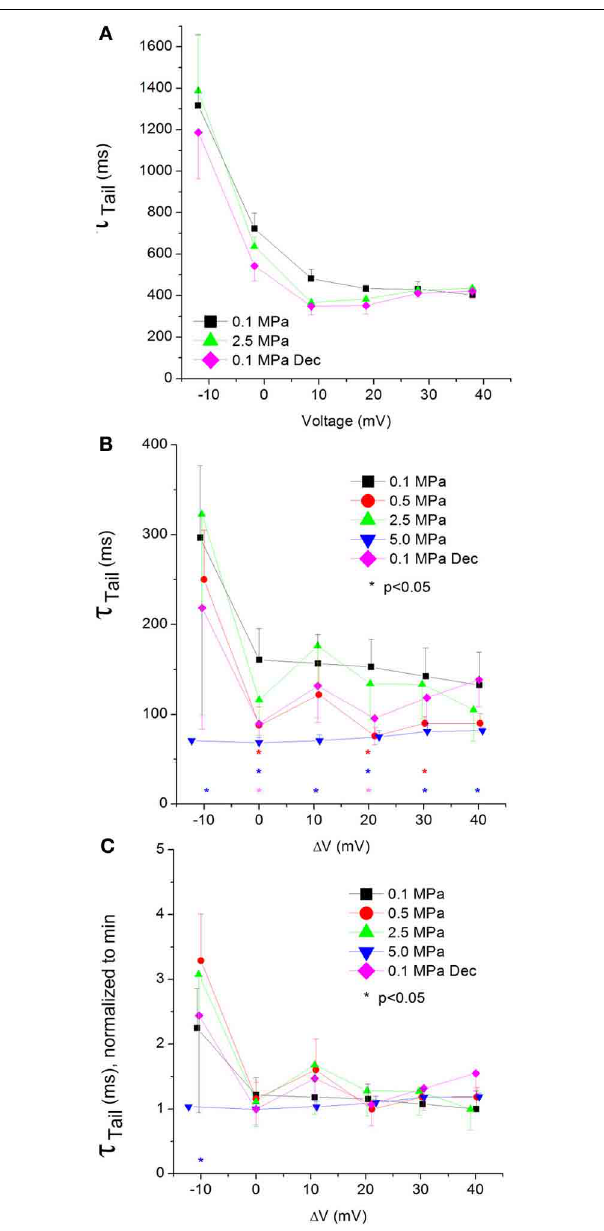
FIGURE 10 | Tail current time constant ( Tail ) in Ca V 1.2 channel. (A) Tail measured in a single oocyte. (B) Pooled data of Tail from 7 to 16 oocytes. Only 5.0 MPa has affected (reduced) Tail throughout the channels’ activity range. (C) Normalized Tail : each curve is normalized to its own minimal value and corresponds to its pertinent curve in (B) . Pressures are color indicated. Statistical significance for each point on the curve is indicated by corresponding color asterisks. Holding potential is expressed as in Figure 2 . Dec indicates